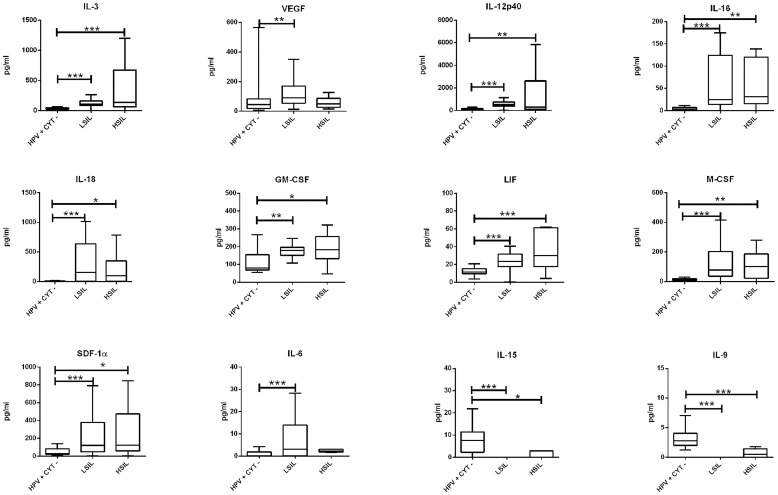
Immune mediators up and down–regulated by HR-HPV infection and severity of induced precancerous lesions (LSIL vs HSIL).The box plots show the expression levels (ρg/mL) of the cytokines found to be statistically significant between HPV+CYT- vs LSIL vs HSIL groups. Data expressed as median values are reported in Table 5. The significant results are marked with asterisks: *p<0.05, **p<0.01, ***p<0.001.